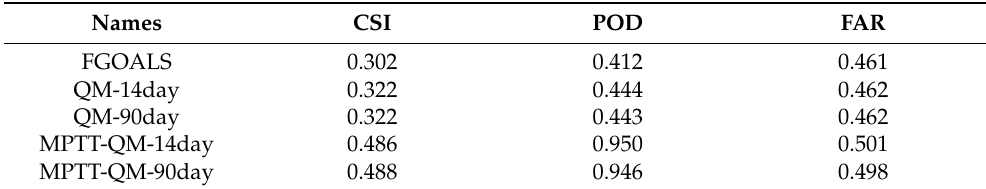
Table 3. Summary of performance statistical metrics for the FGOALS, QM-14day, QM-90day, MPTT- QM-14day, and MPTT-QM-90day precipitation products. The precipitation threshold is set to 0.1